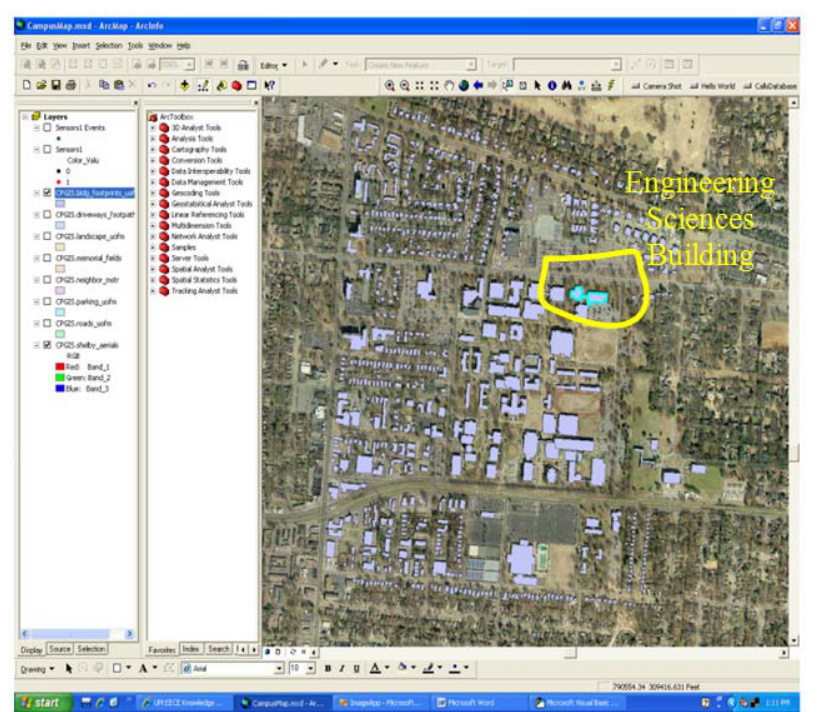
Figure 2. View of the U of M campus with building footprints and the Engineering Sciences Building selected (upper right) for deploying